Question: What style of plot is this figure drawn as?
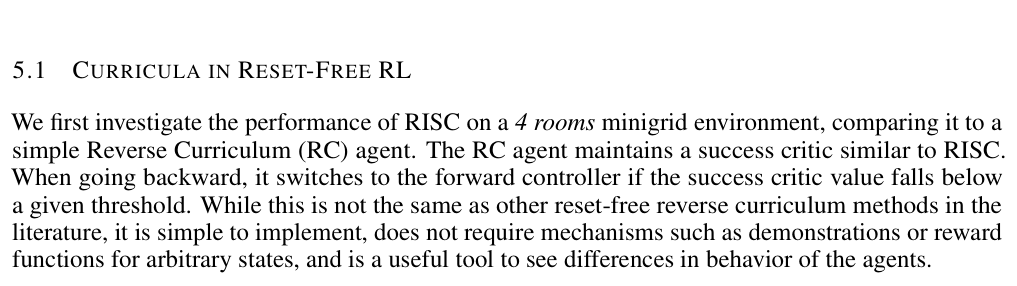
Answer: heatmap